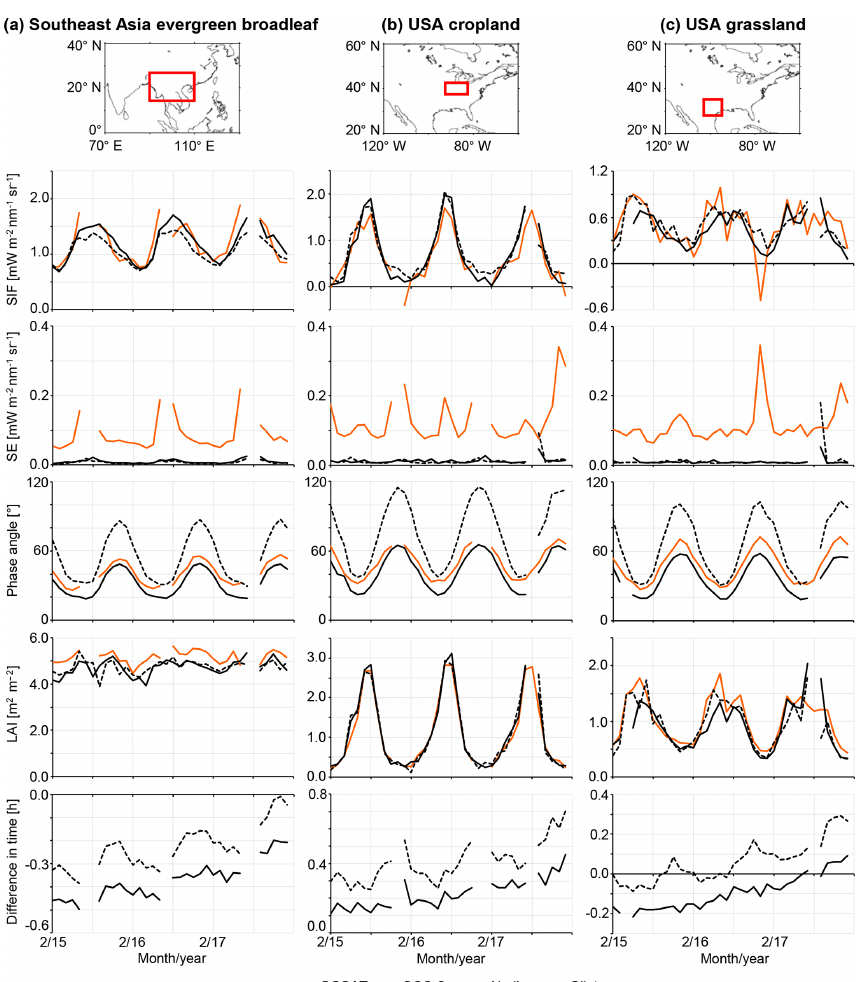
Figure 5. Comparison of the monthly mean SIF between GOSAT and OCO-2 for specific regions where the difference in the observation time is small: (a) evergreen broadleaf forest in Southeast Asia; (b) cropland in the USA; (c) grassland in the USA. In each panel, the target region, SIF value, standard error (SE), phase angle (angle between observation direction and incident sunlight), LAI, and difference in local time of the observation (GOSAT – OCO-2) are presented. Only months with more than four data points are